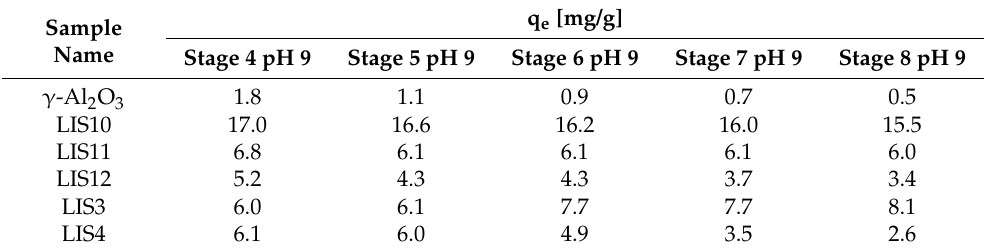
Table 3. Lithium-ion capacity for sorbents selected on the basis of screening tests. Lithium ion capacity was measured in solutions typical for the last five stages of screening